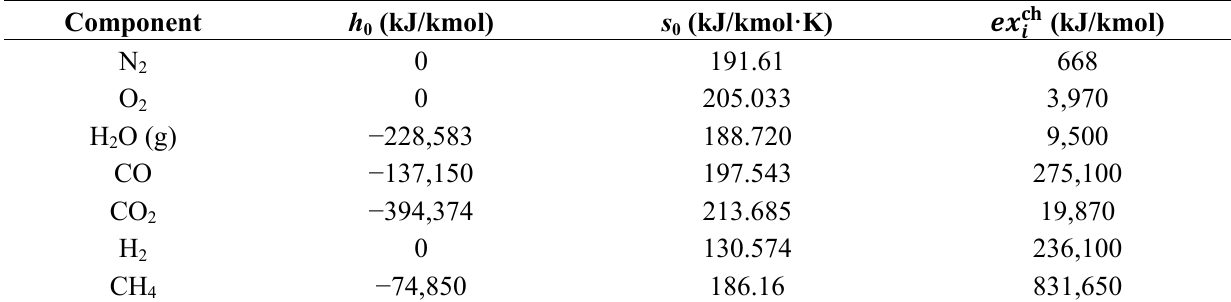
Table 3. Specific enthalpy, entropy and standard chemical exergy values of gaseous components